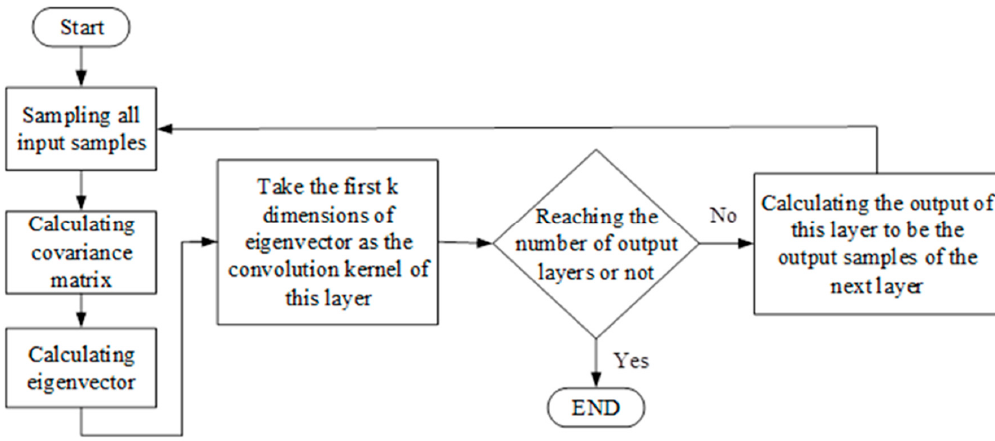
Figure 8. Flowchart of parameter calculations of convolution kernels.